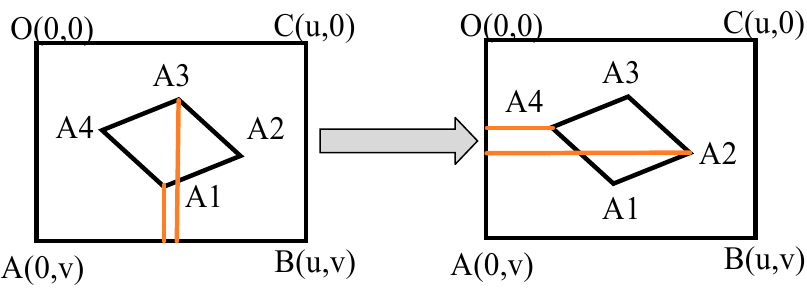
Figure 6. Recognition method of the apex of the vertical channel.